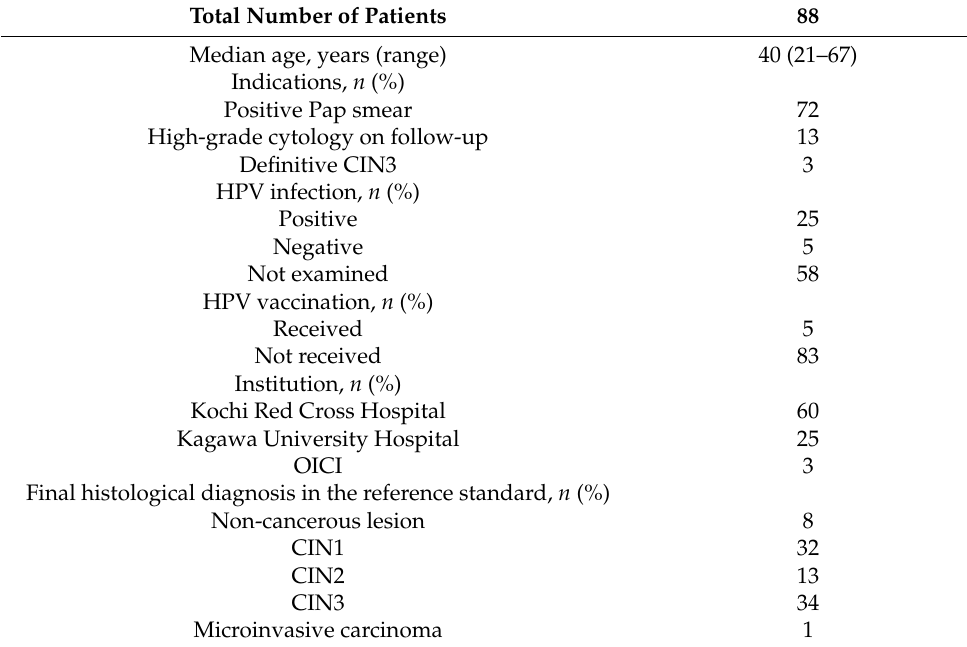
Table 1. Patients’ baseline demographics and clinical characteristics.